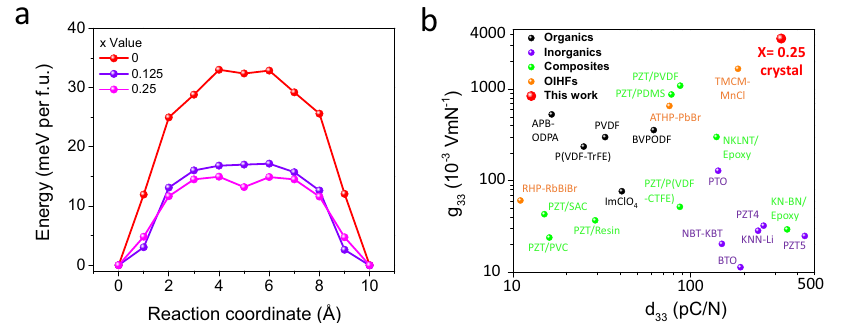
Fig. 3 | Switching barrier simulation and piezoelectricity comparison. a MinimumenergypathscalculatedusingDFTmethod. b g 33 and d 33 comparisonof different materials (see Supplementary Table 2 for reference and details). For